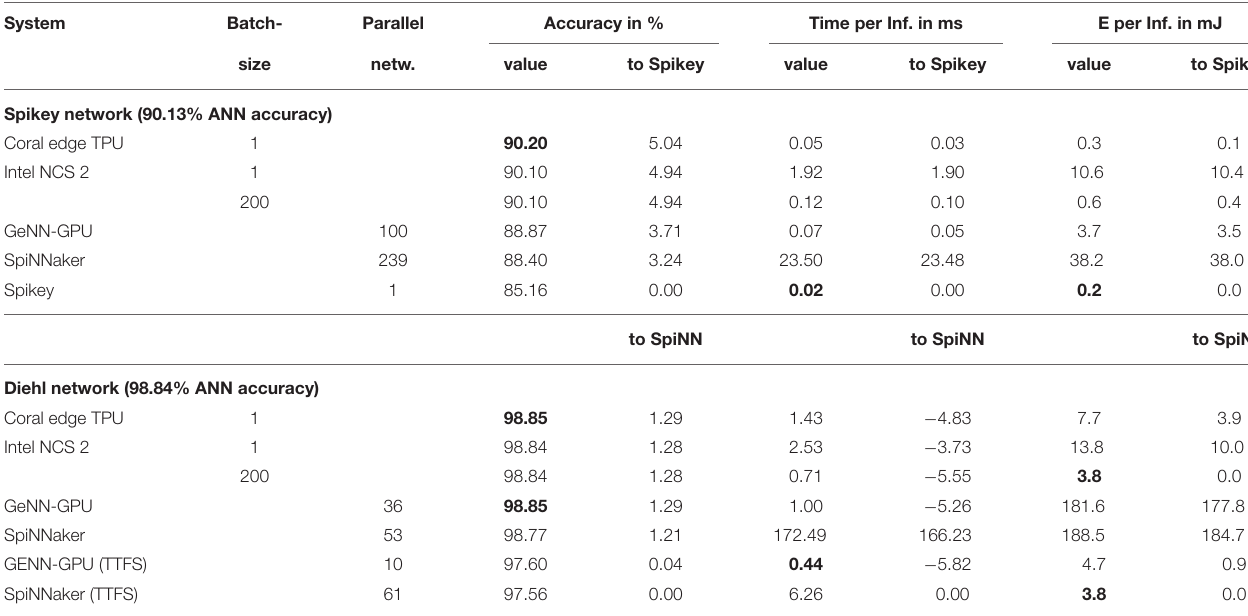
TABLE 8 | The table reports time and energy per inference in SNNs compared to ANN